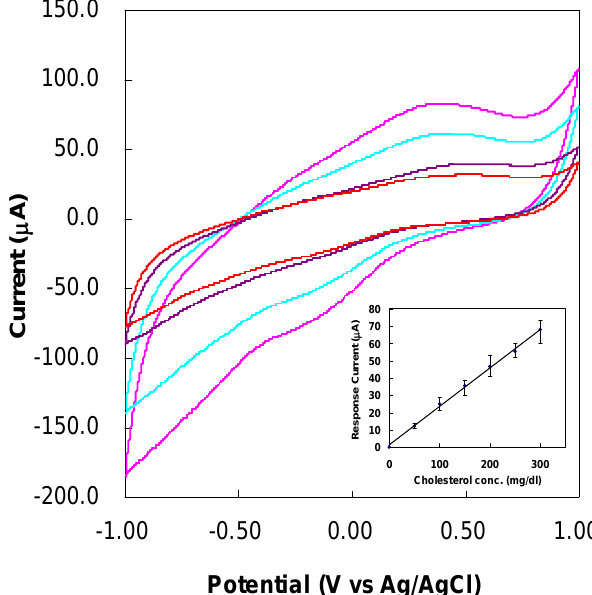
Figure 7. Cyclic voltammograms for cholesterol bioprobe at 100 mV/s scan rate with different cholesterol concentrations. Inset: Amperometric response for bioprobe (oxidation peaks) as a function of cholesterol concentration. The error bars indicates the variation from five independent measurements.